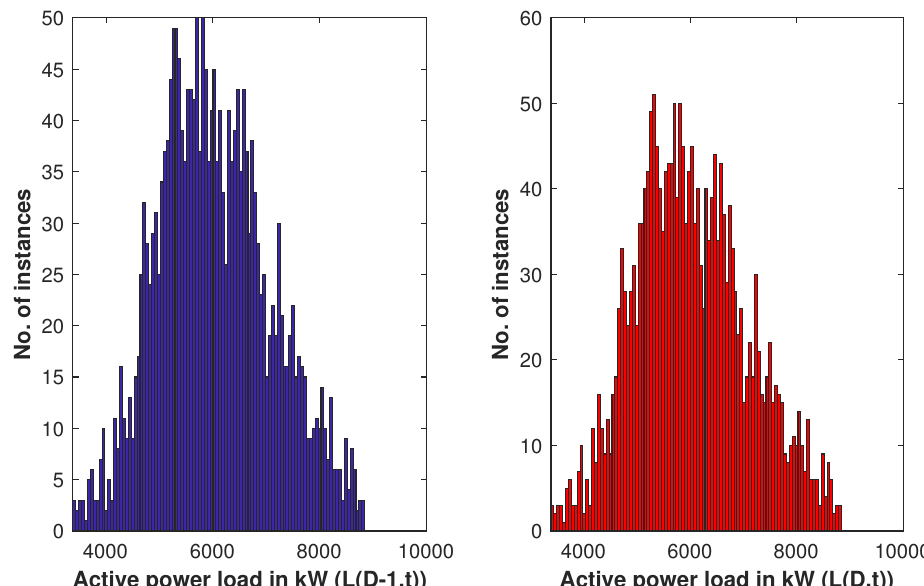
Figure 10. SLR: Data observation using histogram plot.